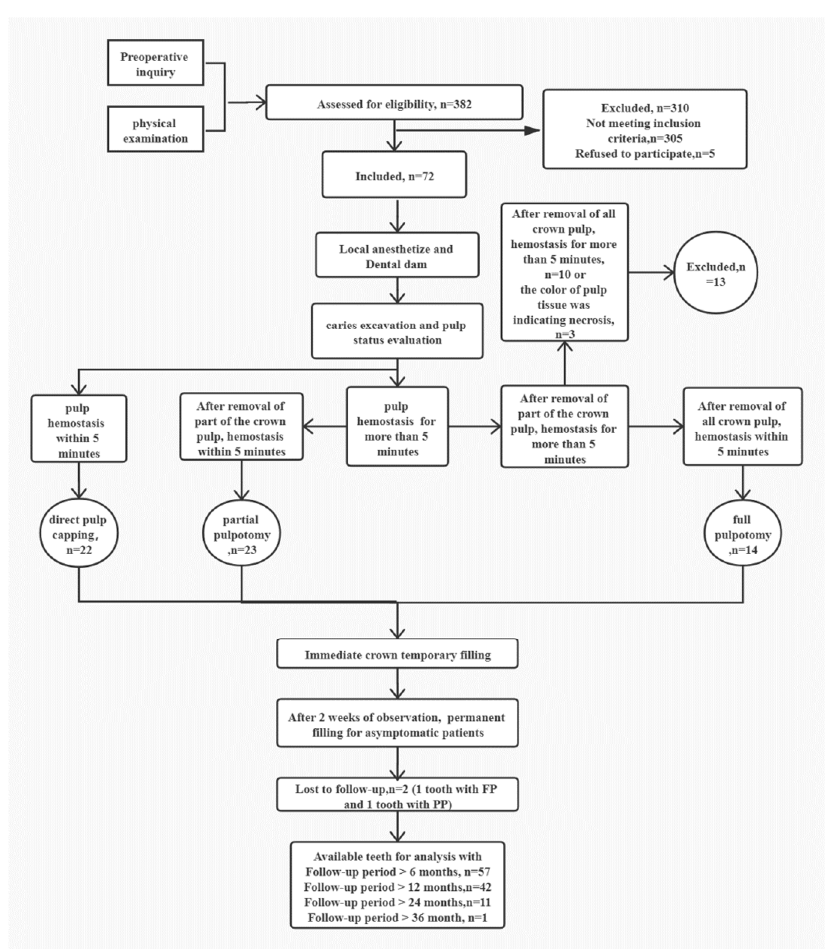
Figure 1. A schematic diagram of the VPT protocol in this clinical study. The number (n) of patients participating in each stage is given. In general, after anesthetizing and isolating the tooth before caries excavation and pulp exposure, pulp bleeding was assessed, and the pulp status was evaluated under microscope. If pulp hemostasis was achieved by direct contact with a cotton pellet moistened with 1% NaOCl within 5 min, DPC was performed. If the hemostasis was more than 5 min, approximately 2–3 mm or more of affected pulpal tissue underneath the exposure site was removed using a sterile high-speed diamond. After this, if the hemostasis was less than 5 min, PP was performed. Otherwise, the full crown pulp was removed to the level of the root canal orifices. Hereafter, if the hemostasis was less than 5 min, FP was performed. Otherwise, the treated tooth was excluded from the study and further treated with RCT or revascularization according to the root development.